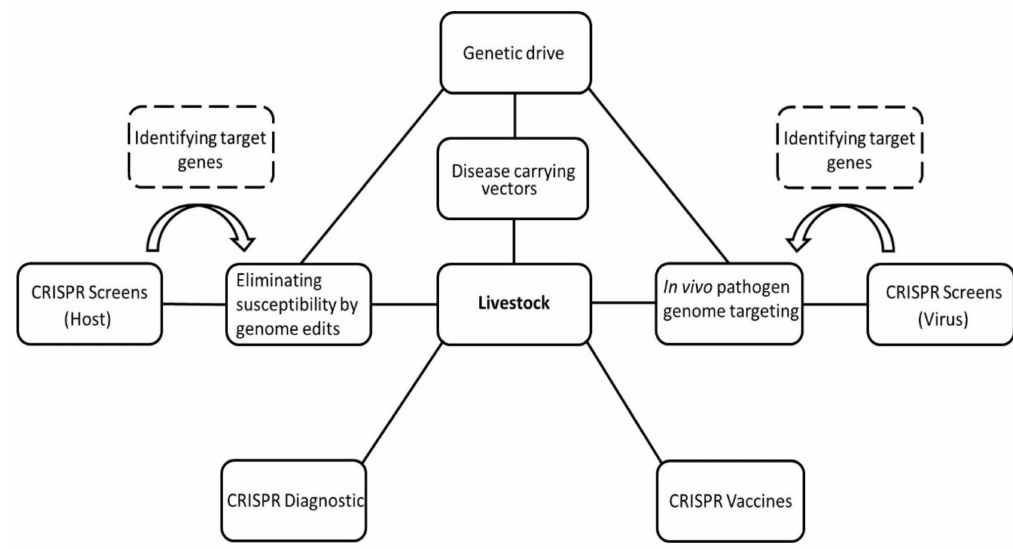
Figure 4. Genome editing as a tool to protect livestock from viral infection: Viral resistance in livestock can be achieved with CRISPR/Cas by either eliminating susceptibility or in vivo pathogen genome targeting. Target genes of the host organism or virus can be identified with CRISPR screens. Gene drives can promote the inheritance of the modified alleles or be integrated into vector species to disrupt transfection cycles. CRISPR/Cas-based diagnostic tools and vaccines can help to prevent and control viral